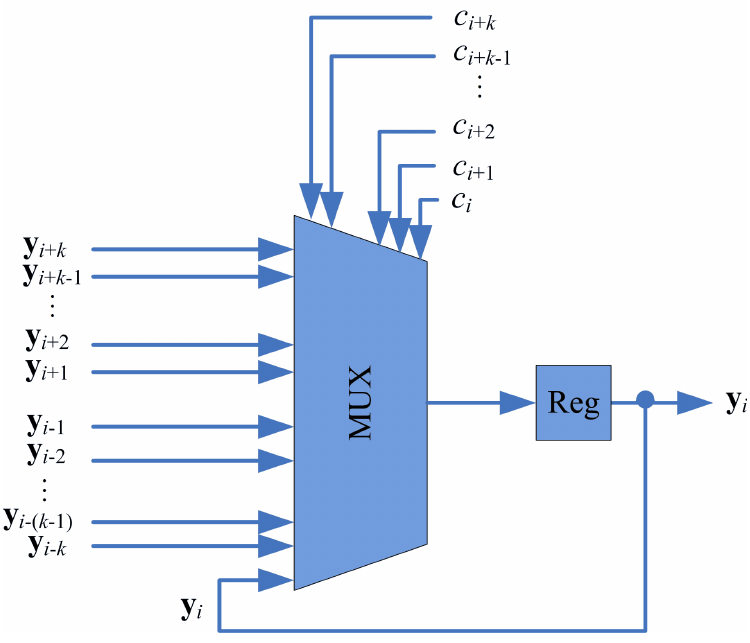
Figure 6. The architecture of the swap unit.